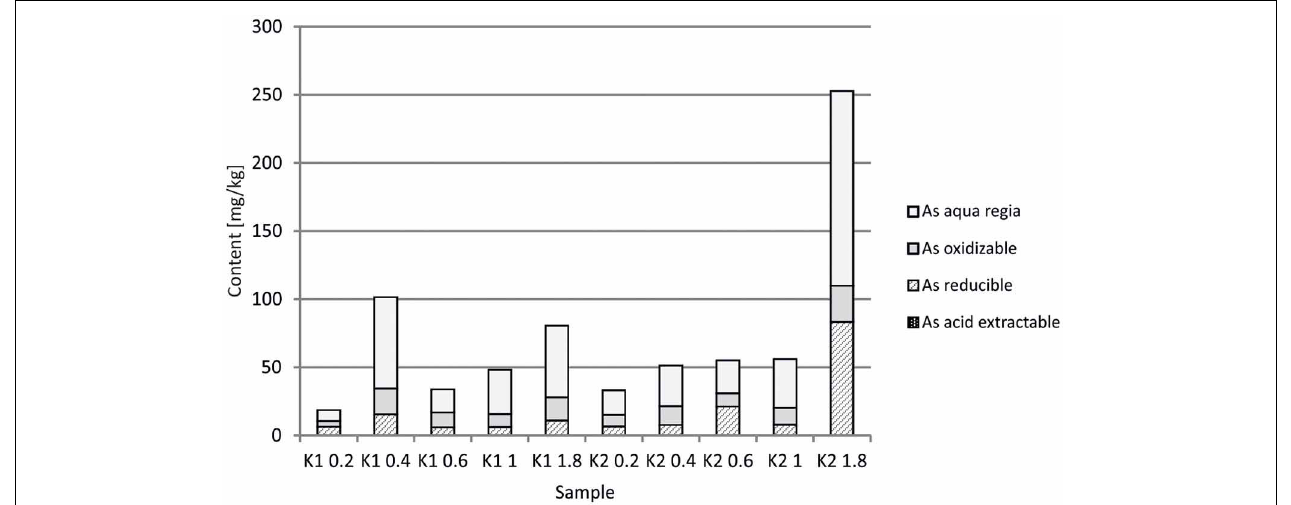
FIGURE 13 | Sequential extraction of samples from Kombat: As.